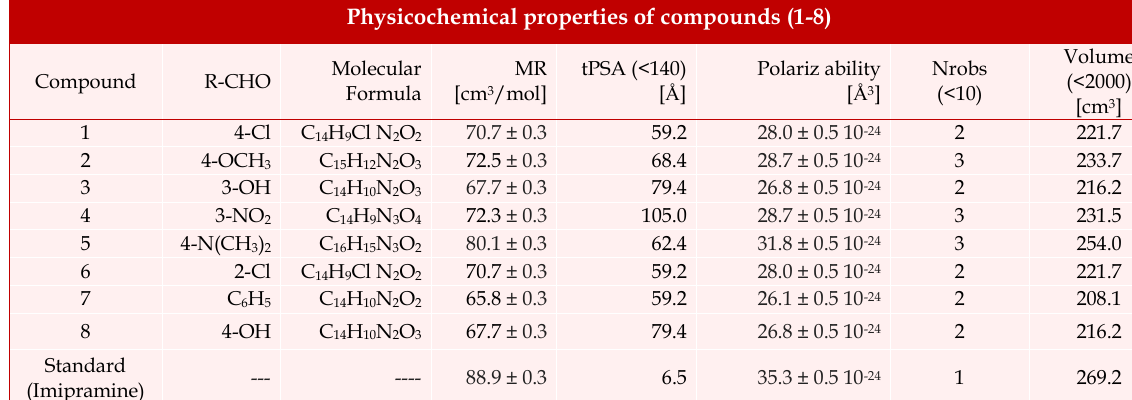
Physicochemical properties of compounds